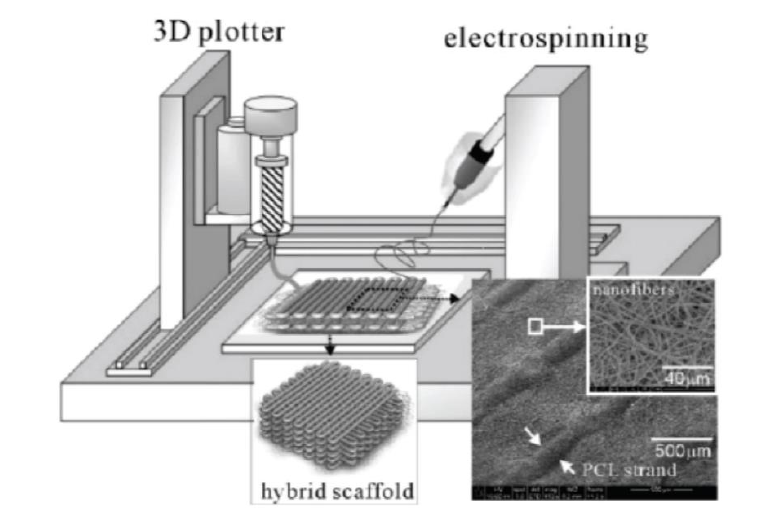
Figure 7. Schematic of 3D printing of hybrid